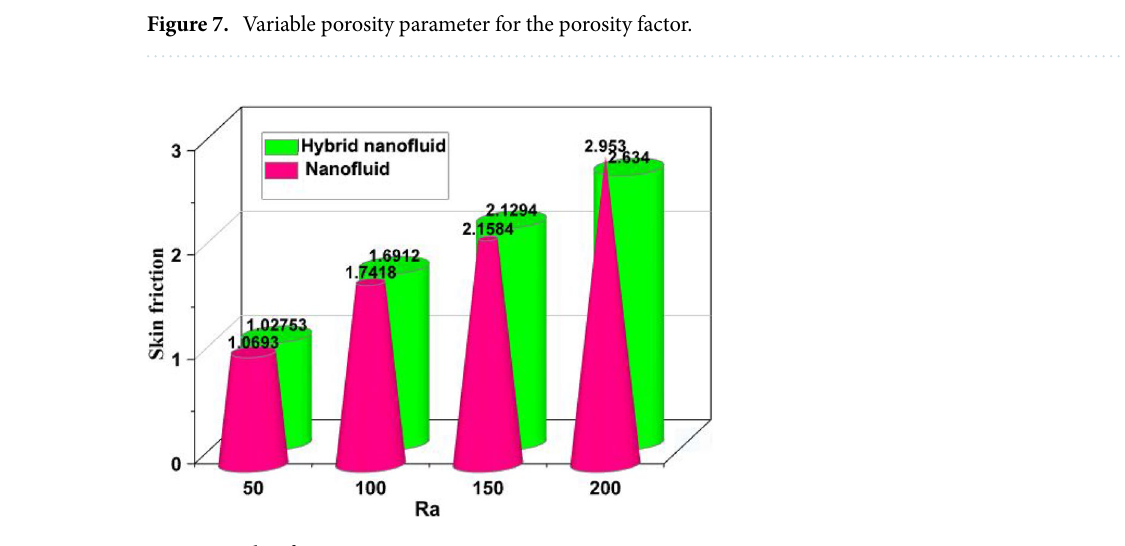
Figure 8. Skin friction versus